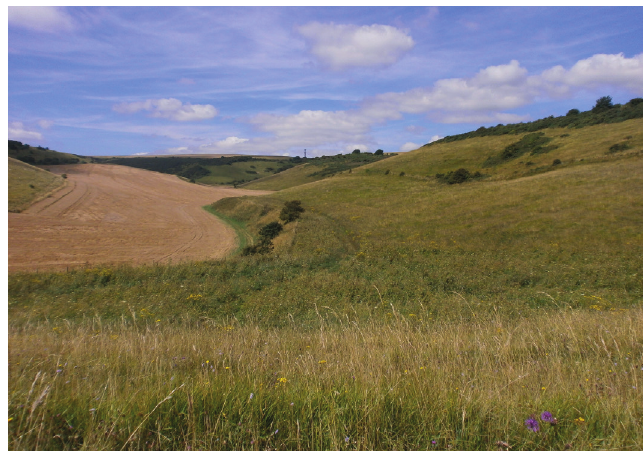
Fig. 3. Grazed chalk downland in Sussex, UK, habitat for the rare Decticus verrucivorus , credit T.